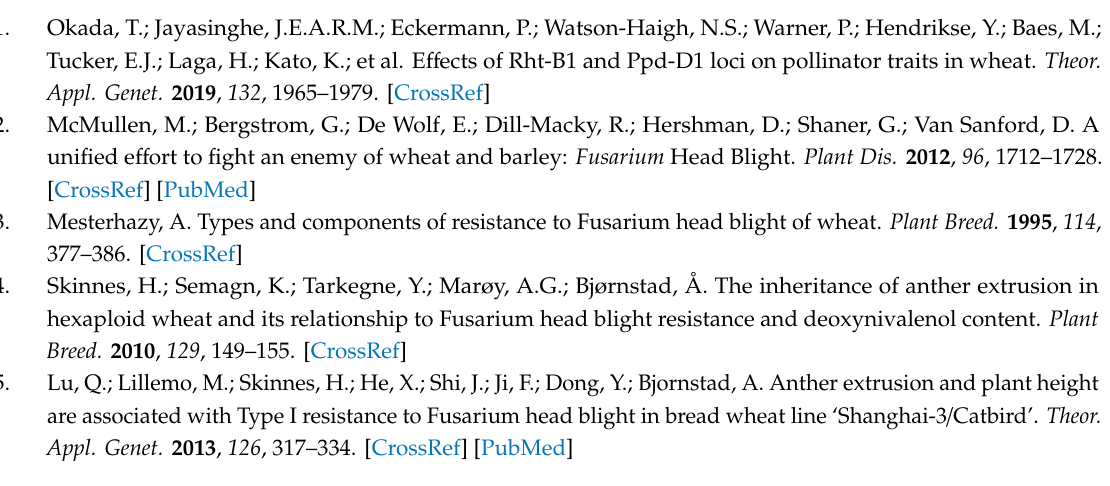
Table S1: Phenotypic data of the four populations investigated in the current study, along with their pedigree information and basic statistics. Table S2. Phenotypic correlations among Fusarium head blight (FHB), Anther extrusion (AE), Plant height (PH) and Days to heading (DH) in ‘NASMA’ × ‘IAS20*5 / H567.71’ (NIH), ‘NASMA’ × ‘RPB709.71 / COC’ (NRC), 16th FHBSN (FHBSN), and ‘Panel of Parents’ (POP) populations. Table S3. QTL for Days to heading (DH) and Plant height (PH) in ‘NASMA’ × ‘IAS20*5 / H567.71’ (NIH) and ‘NASMA’ × ‘RPB709.71 / COC’ (NRC)